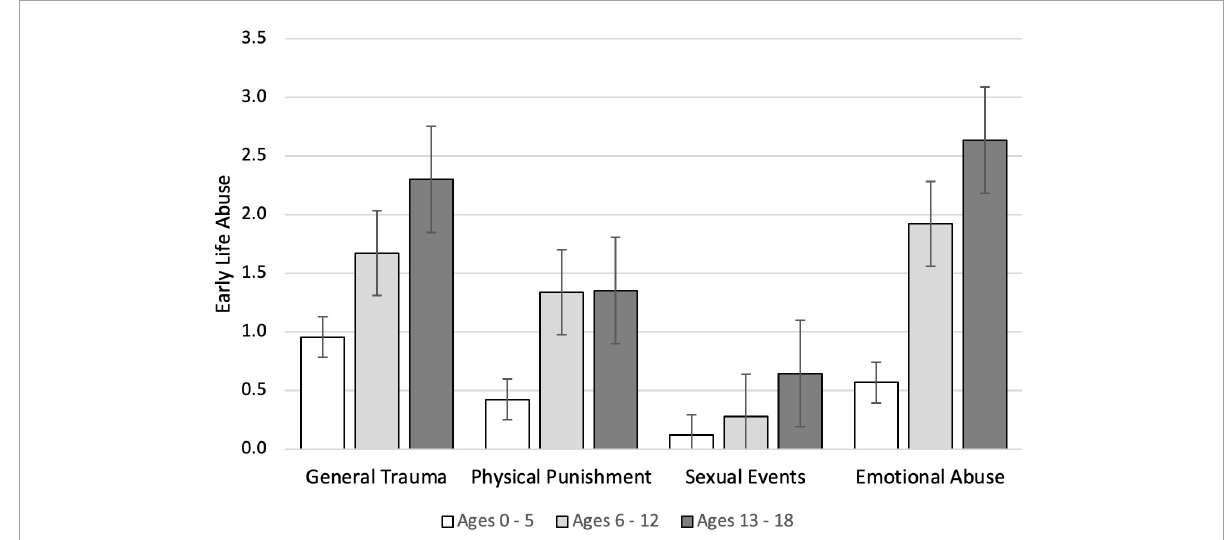
FIGURE3 Mean frequency of early life abuse ( ± SE) as a function of type of abuse and the age range at which they were reported to have been experienced in Study 3. N = 566. Missing data < 1%.